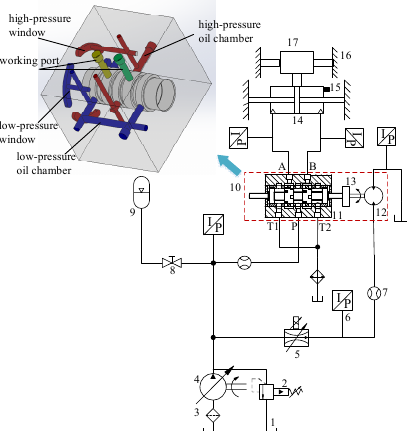
Figure 1. Hydraulic controlled rotary valve excitation system.